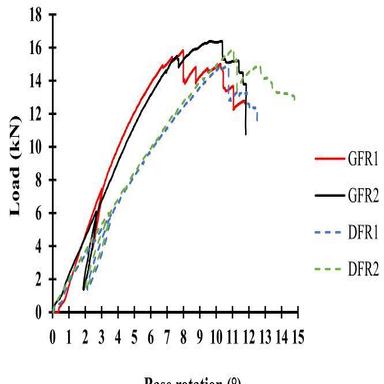
Load-base rotation behaviour of frames with glued and CWDLT members.